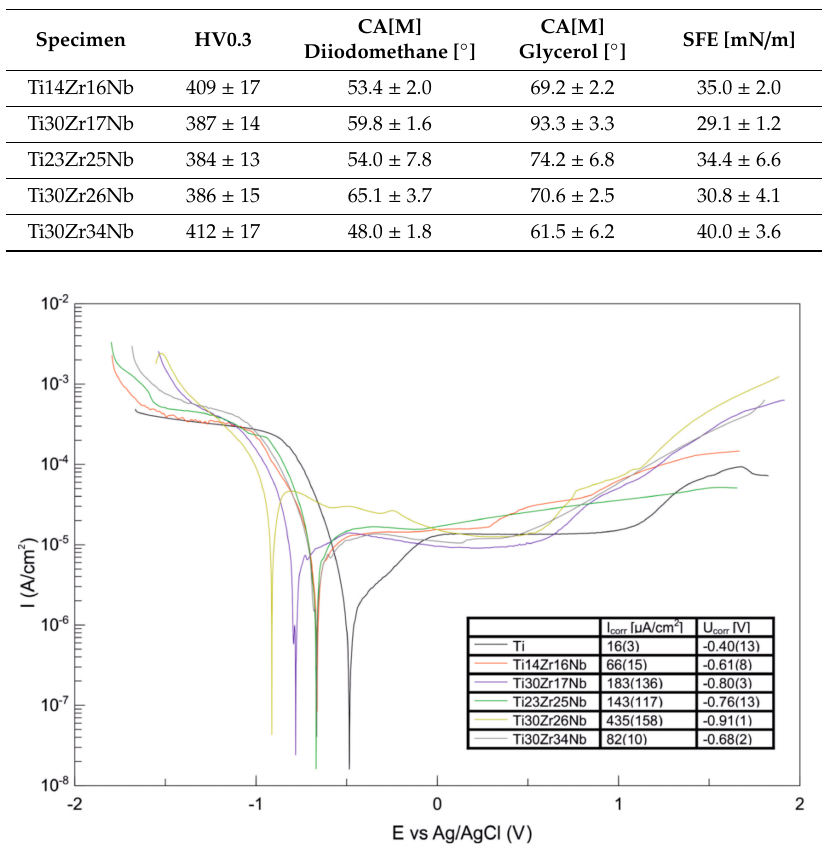
Figure 7. Misorientation angle and grain size distributions from EBSD measurements of α and β phases in Ti14Zr16Nb and Ti23Zr25Nb (only β phase) cold pressed and sintered at 750 ◦ C for 30 min. Table 3. Vickers hardness (HV0.3), surface free energy, diiodomethane, and glycerol contact angles for β and pseudo- β alloys Ti30Zr17Nb, Ti23Zr25Nb, Ti30Zr26Nb, and Ti30Zr34Nb, cold pressed and sintered at 750 ◦ C for 30 min in comparison with dual-phase Ti14Zr16Nb processed in the same conditions. The results were obtained from the group of three replicated measurements.